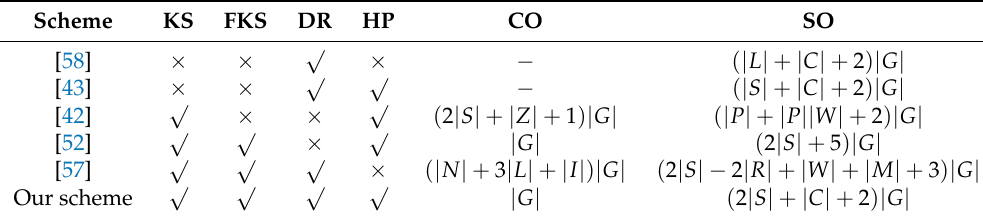
Table 1. Feature comparison of our scheme and other typical schemes † .